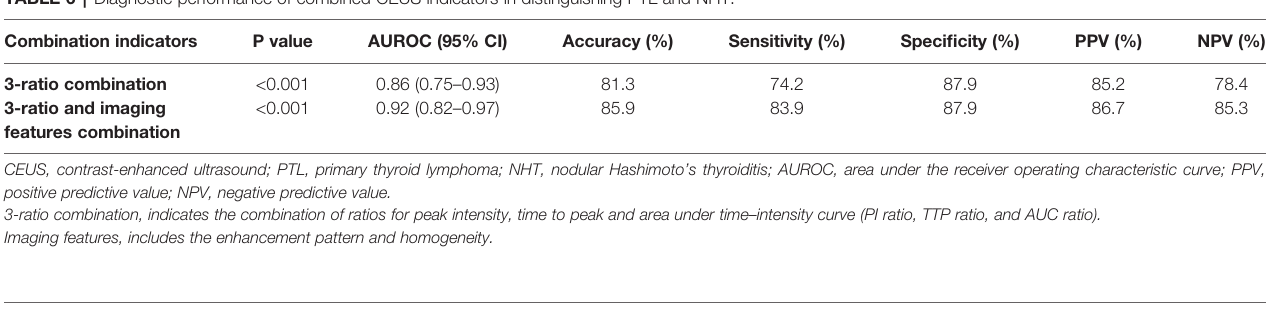
TABLE 6 | Diagnostic performance of combined CEUS indicators in distinguishing PTL and NHT.